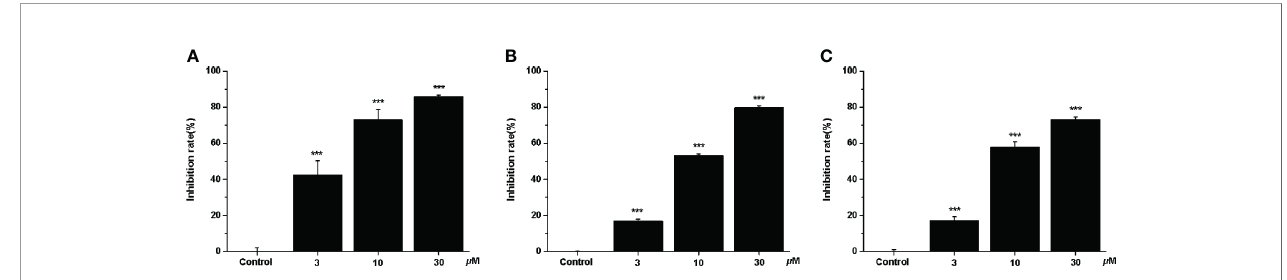
FIGURE 1 | Anti-proliferative effects of casearlucin A treatment on three cell lines. HepG2 (A) , A549 (B) and Hela (C) cells were treated with casearlucin A (3, 10, and 30 m M) for 48 h. Cell viability was examined using MTT assay. DMSO was used as a negative control. The results are presented as means ± SD. *** p < 0.001 versus control